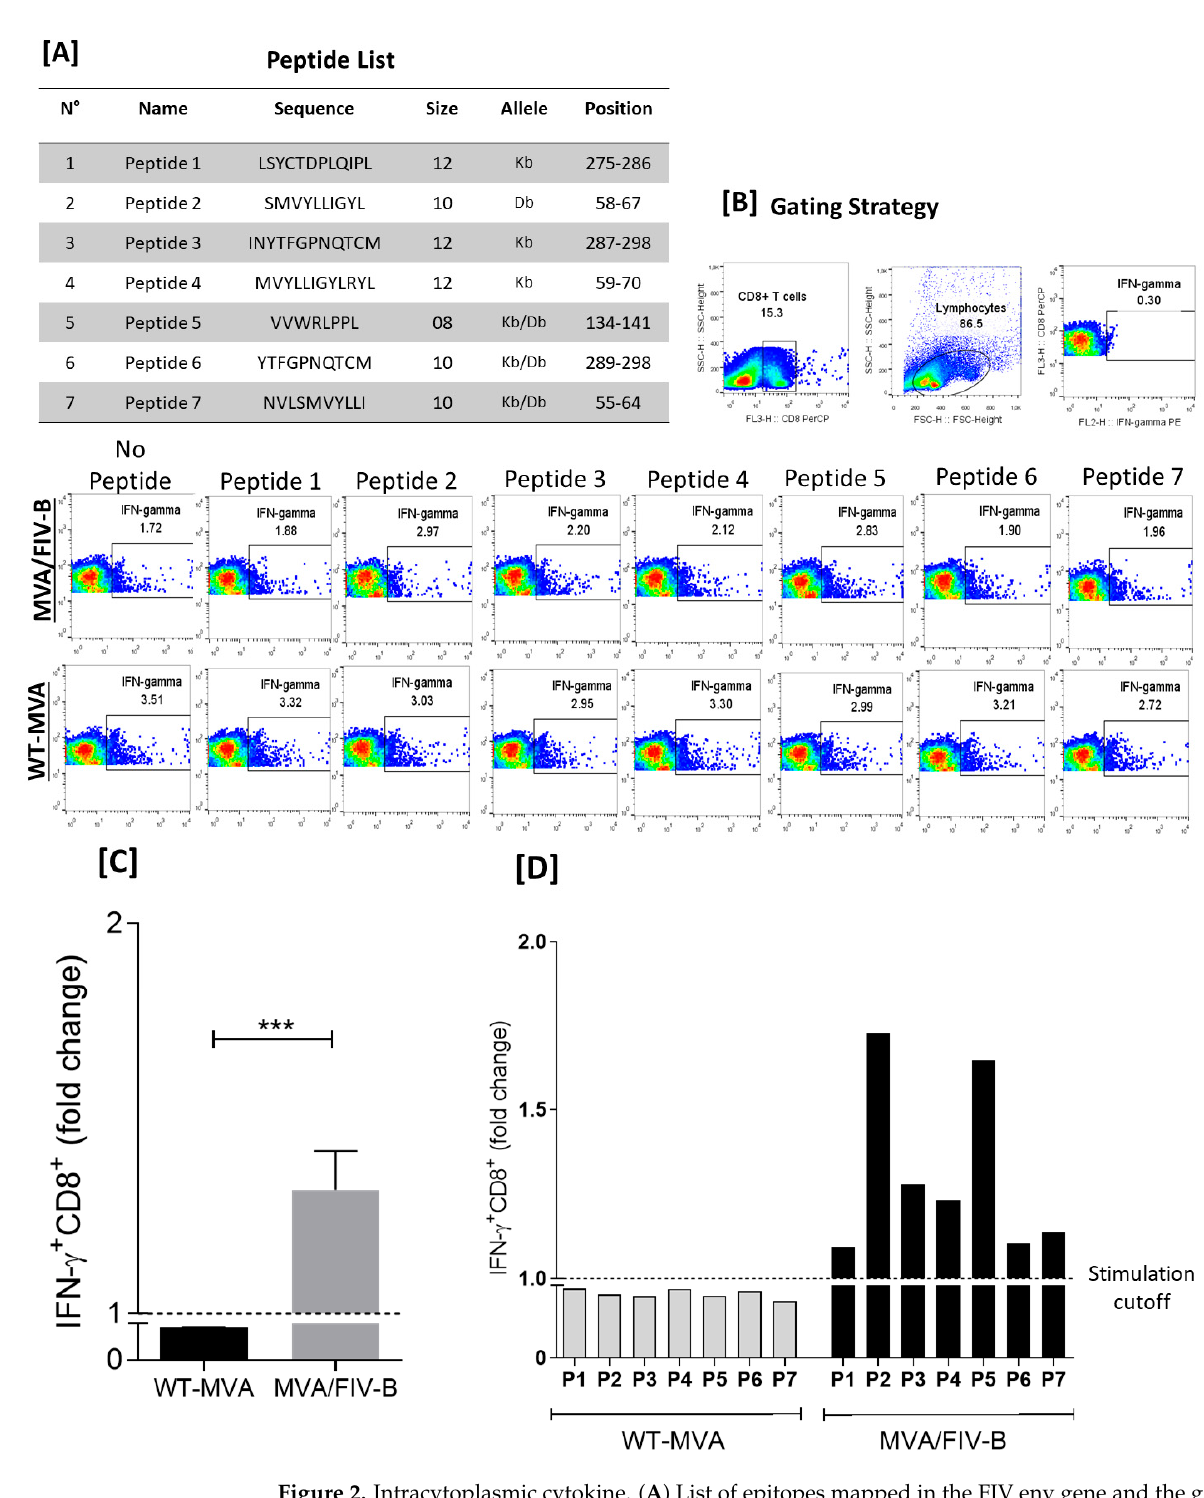
Figure 2. Intracytoplasmic cytokine. ( A ) List of epitopes mapped in the FIV env gene and the gatting strategy used to quantify the production of INF- γ produced by TCD8 + cells. ( B ) Gating strategy and the peptide stimulus in immunized mice with WT-MVA and recombinant MVA/FIV-B. ( C ) Fold change graph of the average stimulation of synthetic peptides in the group of animals immunized with MVA/FIV-B and WT-MVA ( p > 0.001). ( D ) Fold change graph of the individualized stimulation of the 7 synthetic peptides, showing that peptide 2 and peptide 5 present a better stimulation profile, inducing a greater production of INF- γ . Gray bars are form WT-MVA and black bars are form MVA/FIV-B. *** p <